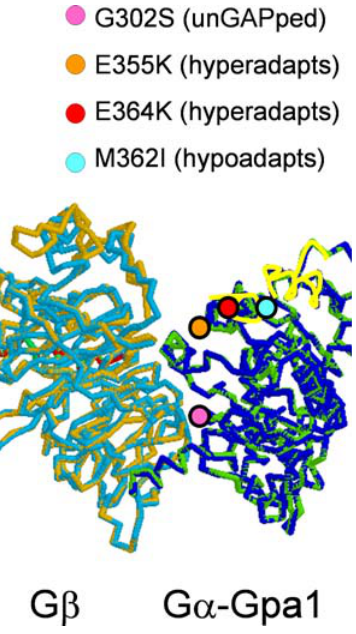
Figure 10. Amino Acid Substitutions in Mutants of the Yeast G- a q Protein Gpa1 A theoretical three-dimensional structure of the yeast Gpa1 G- a protein in complex with the Ste4 protein (G- b ) is shown. The position of four amino acid substitutions with phenotypes of interest is indicated by circles. Two alpha helices are indicated by yellow highlighting of the protein backbone. In higher eukaryotes, these helices are considered to form the interface with G- a q downstream effector proteins. Three mutations affecting adaptation to mating pheromone lie on this face: E355K and E364K both hyper-adapt while the M362I allele described in this work is hypo-adaptive. For reference, the position of a mutation affecting sensitivity to RGS GAP activity, G302S, is also shown. DOI: 10.1371/journal.pgen.0020057.g010